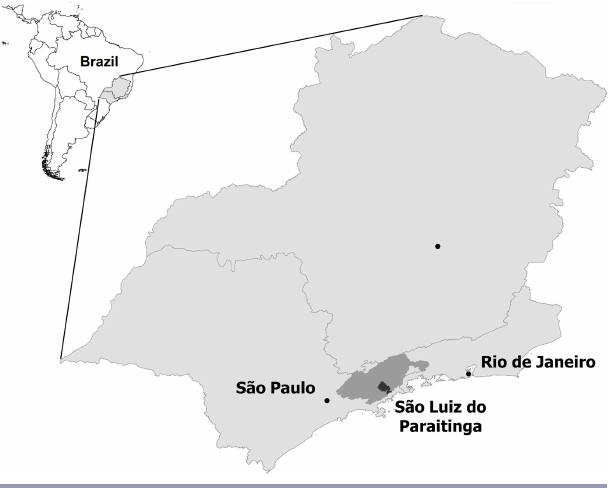
Fig. 1 . The municipality of São Luiz do Paraitinga embedded in the Paraíba Valley (dark grey), southeast Brazil (Image by C. A.